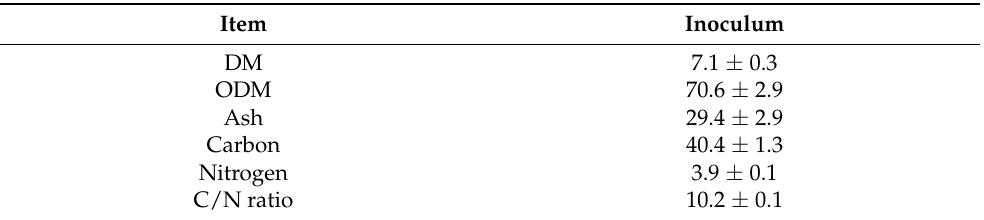
Table 2. Characteristics of anaerobic sludge used as the inoculum for the fermentation process in